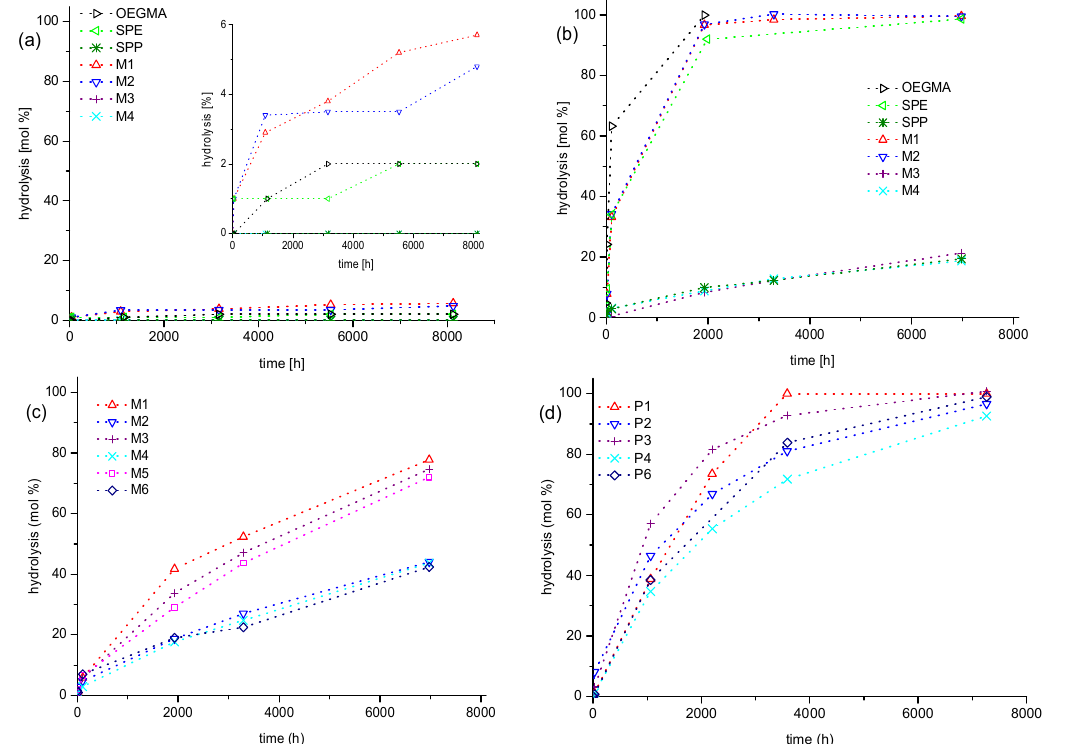
time (h) Figure 6. Kinetics of ester and amide hydrolysis for monomers SPE (  ), SPP (  ), M-1 (  ), M-2 (  ), Figure 6. Kinetics of ester and amide hydrolysis for monomers SPE (  ), SPP (  ), M-1 (  ), M-2 (  ), Figure 6. Kinetics of ester and amide hydrolysis for monomers SPE (  ), SPP (  ), M-1 (  ), M-2 (  ), Figure 6. Kinetics of ester and amide hydrolysis for monomers SPE (  ), SPP (  ), M-1 (  ), M-2 (  ), Figure 6. Kinetics of ester and amide hydrolysis for monomers SPE (  ), SPP (  ), M-1 (  ), M-2 (  ), Figure 6. Kinetics of ester and amide hydrolysis for monomers SPE (  ), SPP (  ), M-1 (  ), M-2 (  ), Figure 6. Kinetics of ester and amide hydrolysis for monomers SPE (  ), SPP (  ), M-1 (  ), M-2 (  ), Figure 6. Kinetics of ester and amide hydrolysis for monomers SPE (  ), SPP (  ), M-1 (  ), M-2 (  ), Figure 6. Kinetics of ester and amide hydrolysis for monomers SPE ( Figure 6. Kinetics of ester and amide hydrolysis for monomers SPE (  ), SPP (  ), M-1 (  ), M-2 (  ), ), Figure 6. Kinetics of ester and amide hydrolysis for monomers SPE (  ), SPP (  ), M-1 (  ), M-2 (  ), M-3 (  ) , M-4 (  ), and OEGMA (  ): ( a ) phosphate buffered saline (PBS) in D 2 O (pH = 7.4) and ( b ) in Figure 6. Kinetics of ester and amide hydrolysis for monomers SPE (  ), SPP (  ), M-1 (  ), M-2 (  ), M-3 (  ) , M-4 (  ), and OEGMA (  ): ( a ) phosphate buffered saline (PBS) in D 2 O (pH = 7.4) and ( b ) in Figure 6. Kinetics of ester and amide hydrolysis for monomers SPE (  ), SPP (  ), M-1 (  ), M-2 (  ), M-3 (  ) , M-4 (  ), and OEGMA (  ): ( a ) phosphate buffered saline (PBS) in D 2 O (pH = 7.4) and ( b ) in M-3 (  ) , M-4 (  ), and OEGMA (  ): ( a ) phosphate buffered saline (PBS) in D 2 O (pH = 7.4) and ( b ) in M-3 (  ) , M-4 (  ), and OEGMA (  ): ( a ) phosphate buffered saline (PBS) in D 2 O (pH = 7.4) and ( b ) in M-3 (  ) , M-4 (  ), and OEGMA (  ): ( a ) phosphate buffered saline (PBS) in D 2 O (pH = 7.4) and ( b ) in M-3 (  ) , M-4 (  ), and OEGMA (  ): ( a ) phosphate buffered saline (PBS) in D 2 O (pH = 7.4) and ( b ) in M-3 (  ) , M-4 (  ), and OEGMA (  ): ( a ) phosphate buffered saline (PBS) in D 2 O (pH = 7.4) and ( b ) in M-3 (  ) , M-4 (  ), and OEGMA (  ): ( a ) phosphate buffered saline (PBS) in D 2 O (pH = 7.4) and ( b ) in M-3 (  ) , M-4 (  ), and OEGMA (  ): ( a ) phosphate buffered saline (PBS) in D 2 O (pH = 7.4) and ( b ) in ), and OEGMA ( ): ( a ) phosphate buffered saline (PBS) in D 2 O (pH = 7.4) and ( b ) in 1 M DCl in D 2 O (pH = 0); kinetics of sulfate hydrolysis for sulfabetaines in 1 M DCl in D 2 O (pH = 0): M-3 (  ) , M-4 (  ), and OEGMA (  ): ( a ) phosphate buffered saline (PBS) in D 2 O (pH = 7.4) and ( b ) in 1 M DCl in D 2 O (pH = 0); kinetics of sulfate hydrolysis for sulfabetaines in 1 M DCl in D 2 O (pH = 0): M-3 (  ) , M-4 (  ), and OEGMA (  ): ( a ) phosphate buffered saline (PBS) in D 2 O (pH = 7.4) and ( b ) in 1 M DCl in D 2 O (pH = 0); kinetics of sulfate hydrolysis for sulfabetaines in 1 M DCl in D 2 O (pH = 0): 1 M DCl in D 2 O (pH = 0); kinetics of sulfate hydrolysis for sulfabetaines in 1 M DCl in D 2 O (pH = 0): 1 M DCl in D 2 O (pH = 0); kinetics of sulfate hydrolysis for sulfabetaines in 1 M DCl in D 2 O (pH = 0): 1 M DCl in D 2 O (pH = 0); kinetics of sulfate hydrolysis for sulfabetaines in 1 M DCl in D 2 O (pH = 0): 1 M DCl in D 2 O (pH = 0); kinetics of sulfate hydrolysis for sulfabetaines in 1 M DCl in D 2 O (pH = 0): Figure 6. Kinetics of ester and amide hydrolysis for monomers SPE (  ), SPP (  ), M-1 (  ), M-2 (  ), 1 M DCl in D 2 O (pH = 0); kinetics of sulfate hydrolysis for sulfabetaines in 1 M DCl in D 2 O (pH = 0): 1 M DCl in D 2 O (pH = 0); kinetics of sulfate hydrolysis for sulfabetaines in 1 M DCl in D 2 O (pH = 0): Figure 6. Kinetics of ester and amide hydrolysis for monomers SPE (  ), SPP (  ), M-1 (  ), M-2 (  ), 1 M DCl in D 2 O (pH = 0); kinetics of sulfate hydrolysis for sulfabetaines in 1 M DCl in D 2 O (pH = 0): 1 M DCl in D 2 O (pH = 0); kinetics of sulfate hydrolysis for sulfabetaines in 1 M DCl in D 2 O (pH = 0): 1 M DCl in D 2 O (pH = 0); kinetics of sulfate hydrolysis for sulfabetaines in 1 M DCl in D 2 O (pH = 0): ( c ) monomers M-1 (  ), M-2 (  ), M-3 (  ) , M-4 (  ) , M-5 (  ), M-6 (  ) and ( d ) polymers P-1 (  ), P-2 1 M DCl in D 2 O (pH = 0); kinetics of sulfate hydrolysis for sulfabetaines in 1 M DCl in D 2 O (pH = 0): Figure 6. Kinetics of ester and amide hydrolysis for monomers SPE (  ), SPP (  ), M-1 (  ), M-2 (  ), ( c ) monomers M-1 (  ), M-2 (  ), M-3 (  ) , M-4 (  ) , M-5 (  ), M-6 (  ) and ( d ) polymers P-1 (  ), P-2 ( c ) monomers M-1 (  ), M-2 (  ), M-3 (  ) , M-4 (  ) , M-5 (  ), M-6 (  ) and ( d ) polymers P-1 (  ), P-2 Figure 6. Kinetics of ester and amide hydrolysis for monomers SPE (  ), SPP (  ), M-1 (  ), M-2 (  ), ( c ) monomers M-1 (  ), M-2 (  ), M-3 (  ) , M-4 (  ) , M-5 (  ), M-6 (  ) and ( d ) polymers P-1 (  ), P-2 Figure 6. Kinetics of ester and amide hydrolysis for monomers SPE (  ), SPP (  ), M-1 (  ), M-2 (  ), ( c ) monomers M-1 (  ), M-2 (  ), M-3 (  ) , M-4 (  ) , M-5 (  ), M-6 (  ) and ( d ) polymers P-1 (  ), P-2 M-3 (  ) , M-4 (  ), and OEGMA (  ): ( a ) phosphate buffered saline (PBS) in D 2 O (pH = 7.4) and ( b ) in ( c ) monomers M-1 (  ), M-2 (  ), M-3 (  ) , M-4 (  ) , M-5 (  ), M-6 (  ) and ( d ) polymers P-1 (  ), P-2 Figure 6. Kinetics of ester and amide hydrolysis for monomers SPE (  ), SPP (  ), M-1 (  ), M-2 (  ), ( c ) monomers M-1 (  ), M-2 (  ), M-3 (  ) , M-4 (  ) , M-5 (  ), M-6 (  ) and ( d ) polymers P-1 (  ), P-2 M-3 (  ) , M-4 (  ), and OEGMA (  ): ( a ) phosphate buffered saline (PBS) in D 2 O (pH = 7.4) and ( b ) in ( c ) monomers M-1 ( Figure 6. Kinetics of ester and amide hydrolysis for monomers SPE (  ), SPP (  ), M-1 (  ), M-2 (  ), ( c ) monomers M-1 (  ), M-2 (  ), M-3 (  ) , M-4 (  ) , M-5 (  ), M-6 (  ) and ( d ) polymers P-1 (  ), P-2 ( c ) monomers M-1 (  ), M-2 (  ), M-3 (  ) , M-4 (  ) , M-5 (  ), M-6 (  ) and ( d ) polymers P-1 (  ), P-2 (  ), P-3 (  ) , P-4 (  ) , P-5 (  ), P-6 (  ). ( c ) monomers M-1 (  ), M-2 (  ), M-3 (  ) , M-4 (  ) , M-5 (  ), M-6 (  ) and ( d ) polymers P-1 (  ), P-2 M-3 (  ) , M-4 (  ), and OEGMA (  ): ( a ) phosphate buffered saline (PBS) in D 2 O (pH = 7.4) and ( b ) in M-3 (  ) , M-4 (  ), and OEGMA (  ): ( a ) phosphate buffered saline (PBS) in D 2 O (pH = 7.4) and ( b ) in Figure 6. Kinetics of ester and amide hydrolysis for monomers SPE (  ), SPP (  ), M-1 (  ), M-2 (  ), (  ), P-3 (  ) , P-4 (  ) , P-5 (  ), P-6 (  ). (  ), P-3 (  ) , P-4 (  ) , P-5 (  ), P-6 (  ). M-3 (  ) , M-4 (  ), and OEGMA (  ): ( a ) phosphate buffered saline (PBS) in D 2 O (pH = 7.4) and ( b ) in M-3 (  ) , M-4 (  ), and OEGMA (  ): ( a ) phosphate buffered saline (PBS) in D 2 O (pH = 7.4) and ( b ) in 1 M DCl in D 2 O (pH = 0); kinetics of sulfate hydrolysis for sulfabetaines in 1 M DCl in D 2 O (pH = 0): M-3 (  ) , M-4 (  ), and OEGMA (  ): ( a ) phosphate buffered saline (PBS) in D 2 O (pH = 7.4) and ( b ) in 1 M DCl in D 2 O (pH = 0); kinetics of sulfate hydrolysis for sulfabetaines in 1 M DCl in D 2 O (pH = 0): ), P-6 ( (  ), P-3 (  ) , P-4 (  ) , P-5 (  ), P-6 (  ). (  ), P-3 (  ) , P-4 (  ) , P-5 (  ), P-6 (  ). (  ), P-3 (  ) , P-4 (  ) , P-5 (  ), P-6 (  ). 1 M DCl in D 2 O (pH = 0); kinetics of sulfate hydrolysis for sulfabetaines in 1 M DCl in D 2 O (pH = 0): 1 M DCl in D 2 O (pH = 0); kinetics of sulfate hydrolysis for sulfabetaines in 1 M DCl in D 2 O (pH = 0): M-3 (  ) , M-4 (  ), and OEGMA (  ): ( a ) phosphate buffered saline (PBS) in D 2 O (pH = 7.4) and ( b ) in 1 M DCl in D 2 O (pH = 0); kinetics of sulfate hydrolysis for sulfabetaines in 1 M DCl in D 2 O (pH = 0): 1 M DCl in D 2 O (pH = 0); kinetics of sulfate hydrolysis for sulfabetaines in 1 M DCl in D 2 O (pH = 0): ( c ) monomers M-1 (  ), M-2 (  ), M-3 (  ) , M-4 (  ) , M-5 (  ), M-6 (  ) and ( d ) polymers P-1 (  ), P-2 1 M DCl in D 2 O (pH = 0); kinetics of sulfate hydrolysis for sulfabetaines in 1 M DCl in D 2 O (pH = 0): ( c ) monomers M-1 (  ), M-2 (  ), M-3 (  ) , M-4 (  ) , M-5 (  ), M-6 (  ) and ( d ) polymers P-1 (  ), P-2 ( c ) monomers M-1 (  ), M-2 (  ), M-3 (  ) , M-4 (  ) , M-5 (  ), M-6 (  ) and ( d ) polymers P-1 (  ), P-2 ( c ) monomers M-1 (  ), M-2 (  ), M-3 (  ) , M-4 (  ) , M-5 (  ), M-6 (  ) and ( d ) polymers P-1 (  ), P-2 1 M DCl in D 2 O (pH = 0); kinetics of sulfate hydrolysis for sulfabetaines in 1 M DCl in D 2 O (pH = 0): ( c ) monomers M-1 (  ), M-2 (  ), M-3 (  ) , M-4 (  ) , M-5 (  ), M-6 (  ) and ( d ) polymers P-1 (  ), P-2 ( c ) monomers M-1 (  ), M-2 (  ), M-3 (  ) , M-4 (  ) , M-5 (  ), M-6 (  ) and ( d ) polymers P-1 (  ), P-2 (  ), P-3 (  ) , P-4 (  ) , P-5 (  ), P-6 (  ). ( c ) monomers M-1 (  ), M-2 (  ), M-3 (  ) , M-4 (  ) , M-5 (  ), M-6 (  ) and ( d ) polymers P-1 (  ), P-2 (  ), P-3 (  ) , P-4 (  ) , P-5 (  ), P-6 (  ). (  ), P-3 (  ) , P-4 (  ) , P-5 (  ), P-6 (  ). ( c ) monomers M-1 (  ), M-2 (  ), M-3 (  ) , M-4 (  ) , M-5 (  ), M-6 (  ) and ( d ) polymers P-1 (  ), P-2 (  ), P-3 (  ) , P-4 (  ) , P-5 (  ), P-6 (  ). (  ), P-3 (  ) , P-4 (  ) , P-5 (  ), P-6 (  ). (  ), P-3 (  ) , P-4 (  ) , P-5 (  ), P-6 (  ). (  ), P-3 (  ) , P-4 (  ) , P-5 (  ), P-6 (  ).